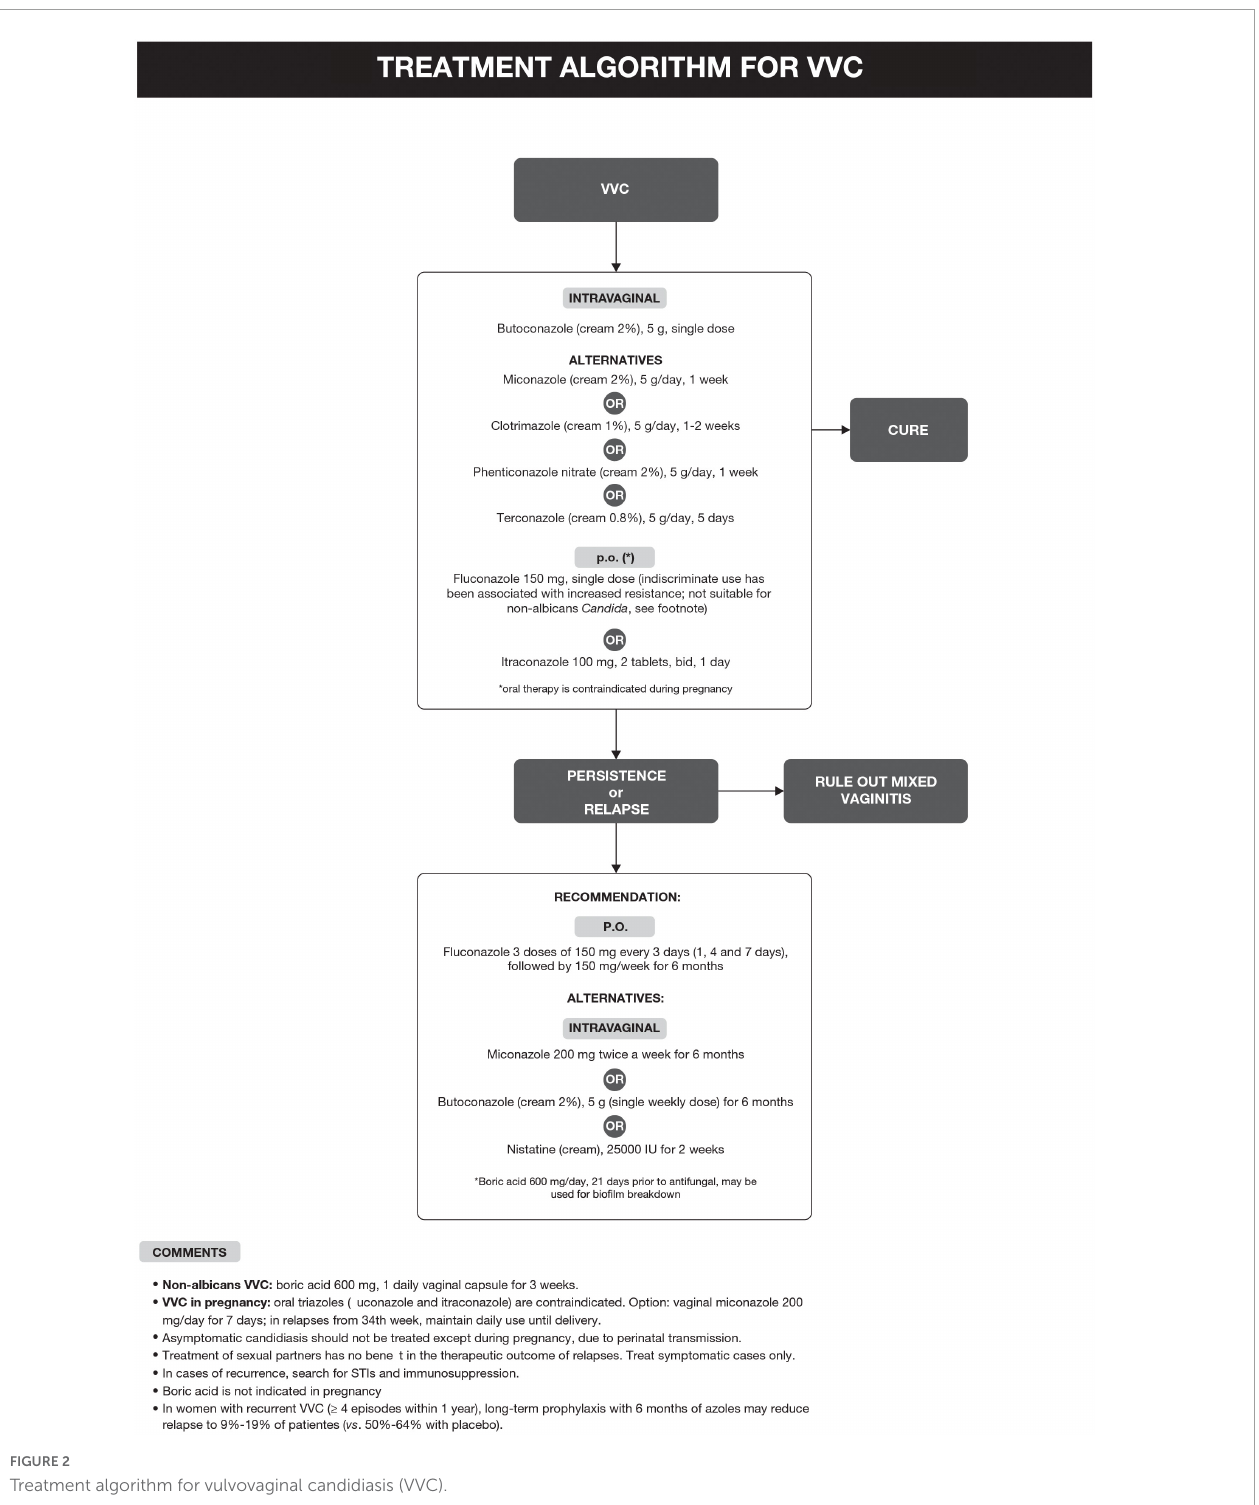
FIGURE2 Treatment algorithm for vulvovaginal candidiasis